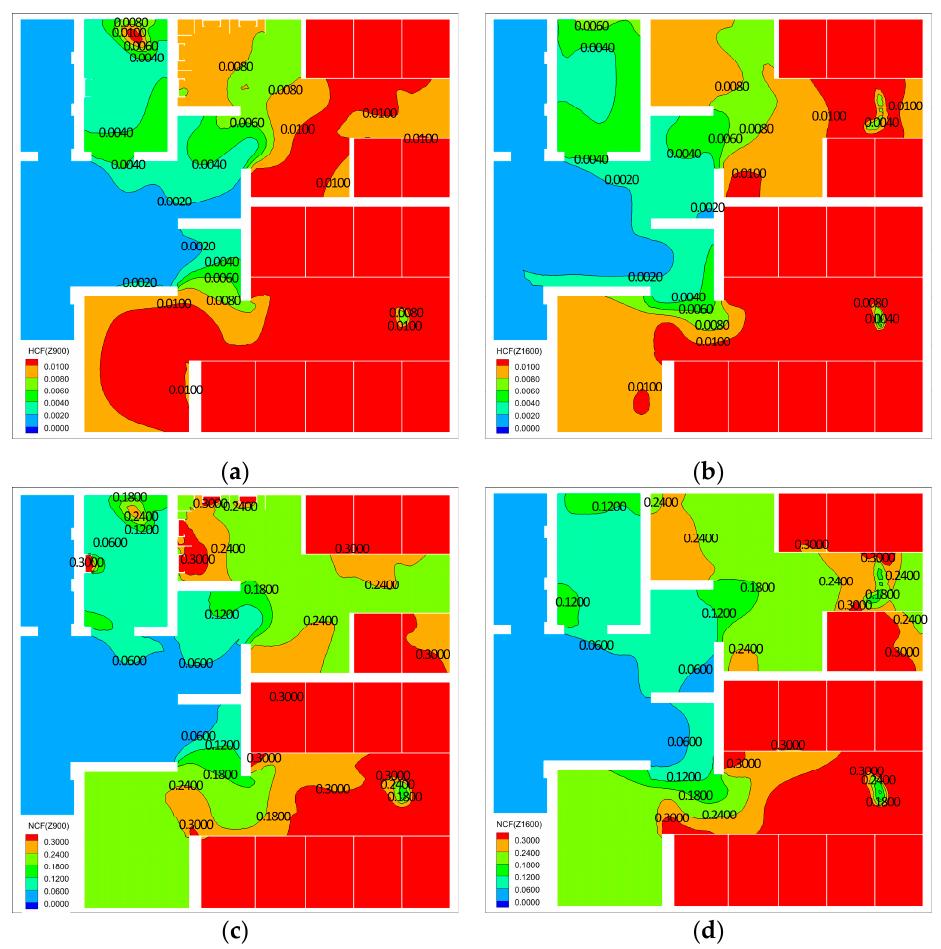
Figure 3. Concentration cloud map of pollutants in Scenario 1. ( a ) H 2 S concentration fraction (Z900); ( b ) H 2 S concentration fraction (Z1600); ( c ) NH 3 concentration fraction (Z900); ( d ) NH 3 con- centration fraction (Z1600).